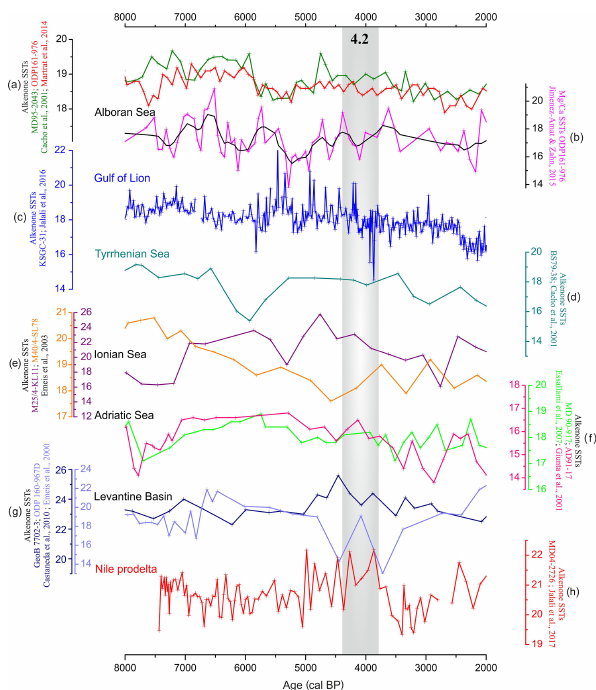
Figure 4. Selected SSTs ( ◦ C). For location, refer to Fig. 1 and for references to Table